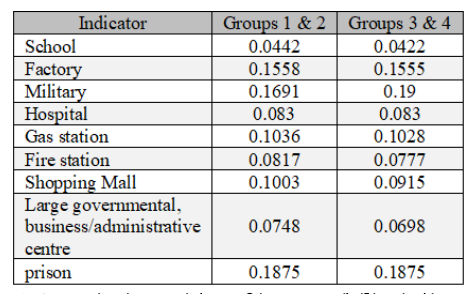
Table 4: Quantitative weights of incompatibility indicators for all groups